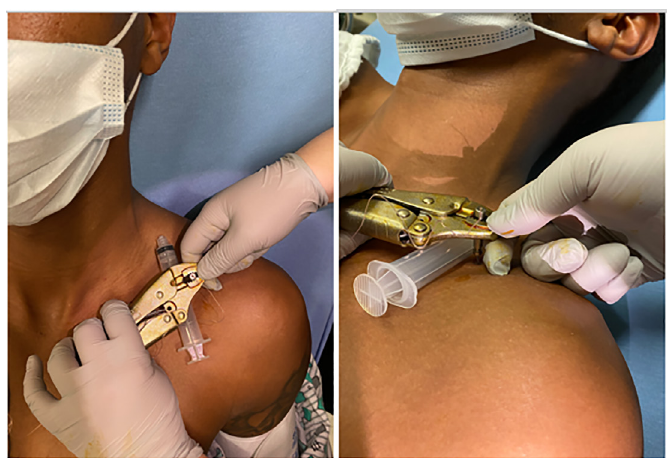
Image 2. Vise-grip locking pliers were used to grasp the metal cylinder, and a 10-cc* syringe was placed below the pliers to act as a fulcrum when downward pressure was applied to the plier